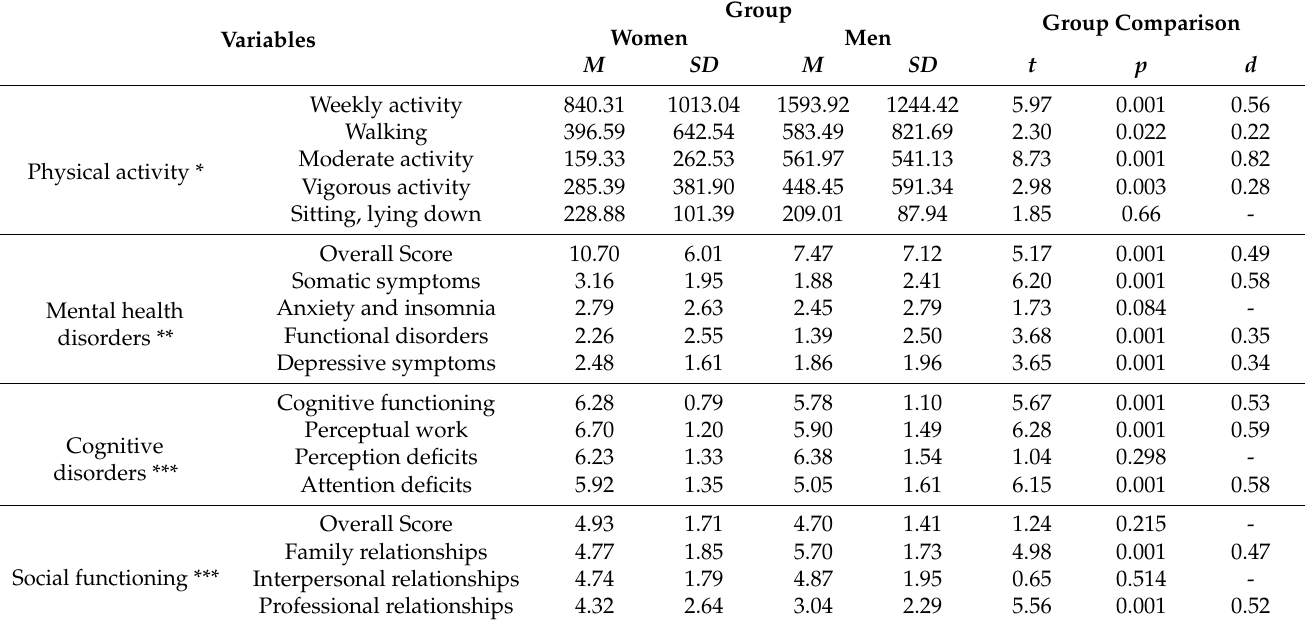
Table 3. Comparison of physical activity, mental health, cognitive processes and social functioning of women and